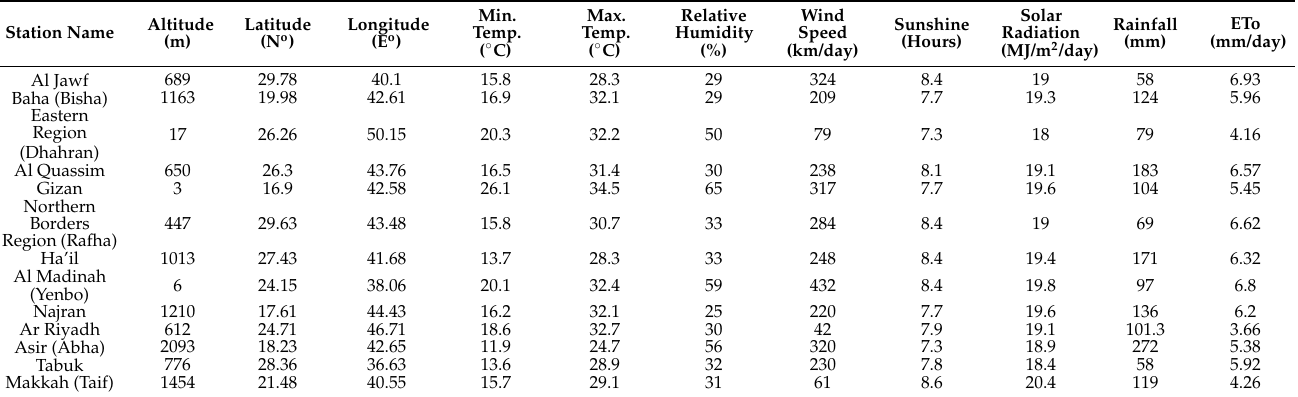
Table 2. Coordinates, altitude and average climatic parameters for the 13 stations between 1991 and 2020 in Saudi